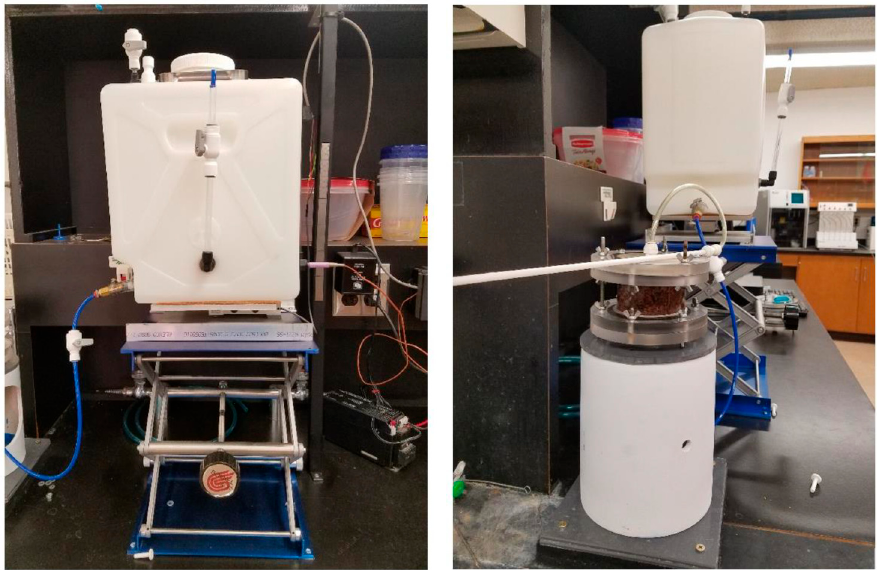
Figure 3. Automated constant head setup for K sat measurements.